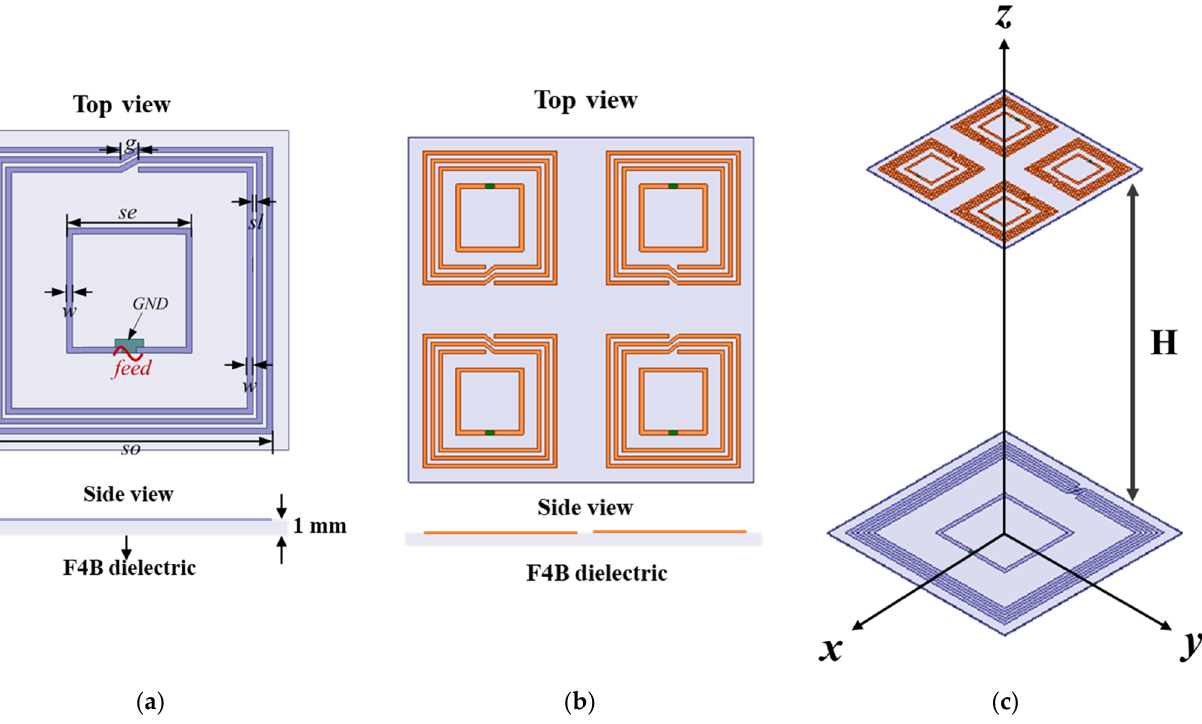
Figure 2. The Tx coil and multiple receivers WPT system. ( a ) Top view and side view of the Tx coil. ( b ) Top view and side view of the Rx coil. ( c ) The conventional multiple receivers WPT system. Table 1. The parameters of the Tx and Rx coils.